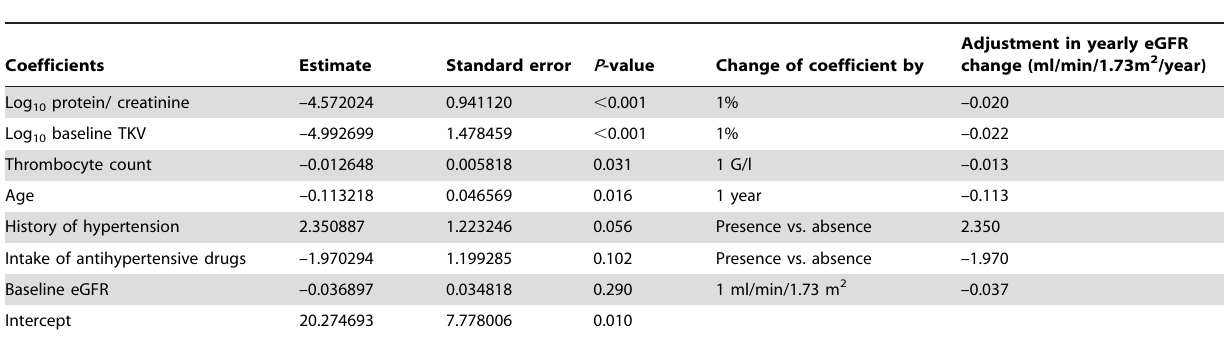
Table 4. Linear regression model with 97% windsorized yearly eGFR change as dependent